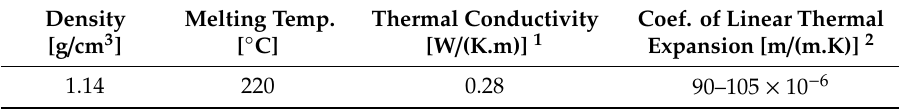
Table 1. Density and thermal properties of Ertalon ® 6 SA [32].